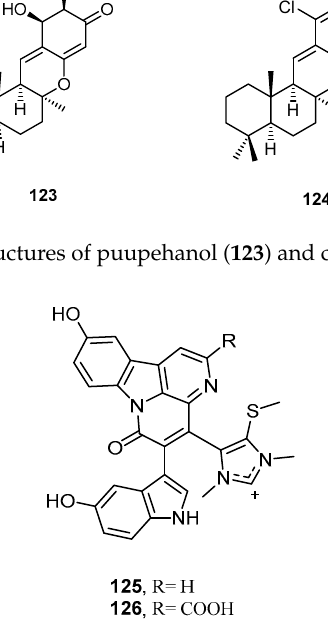
Figure 33. Chemical structures of hyrtimomine D ( 125 ) and hyrtimomine E ( 126 ).